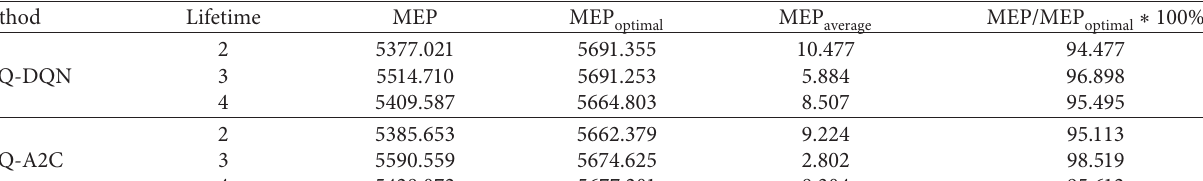
Table 5: MEP for proposed algorithm and optimal